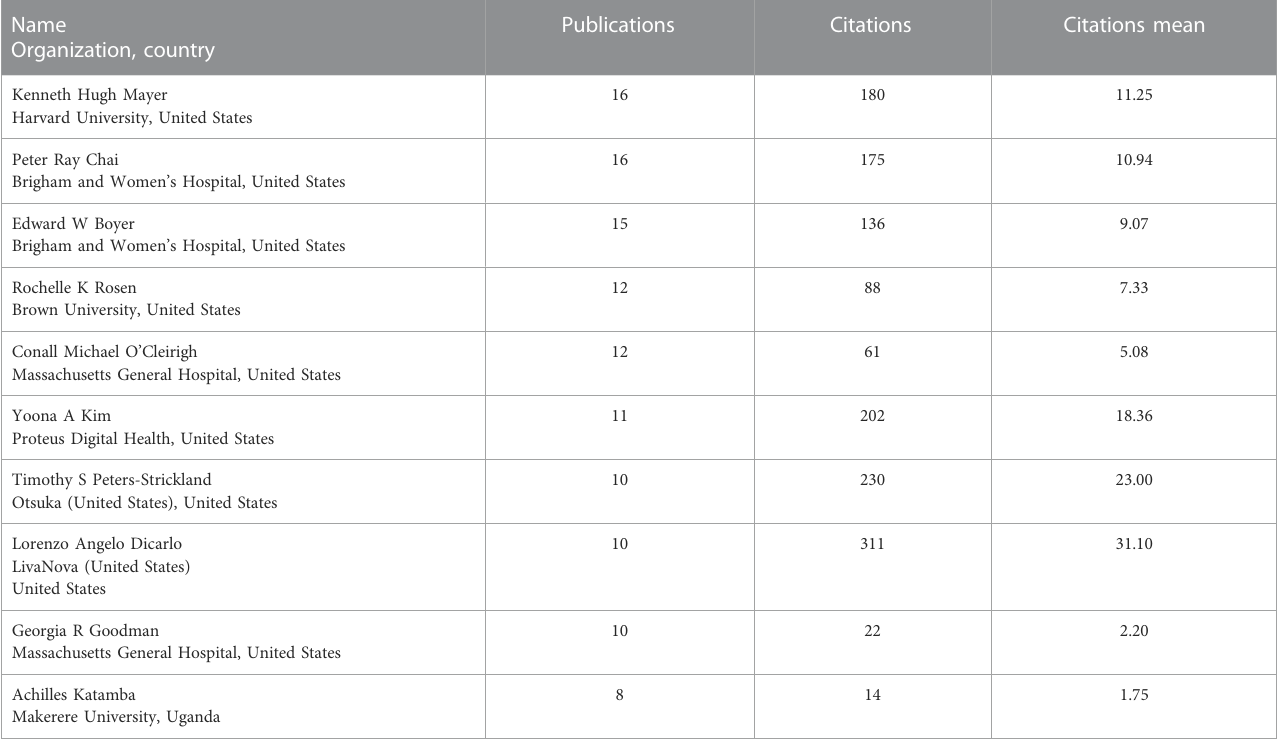
TABLE 3 Leading scientists in publishing and scienti fi c activity in the fi eld of digital pills for the period January 2012 to July 2022. Name Organization,